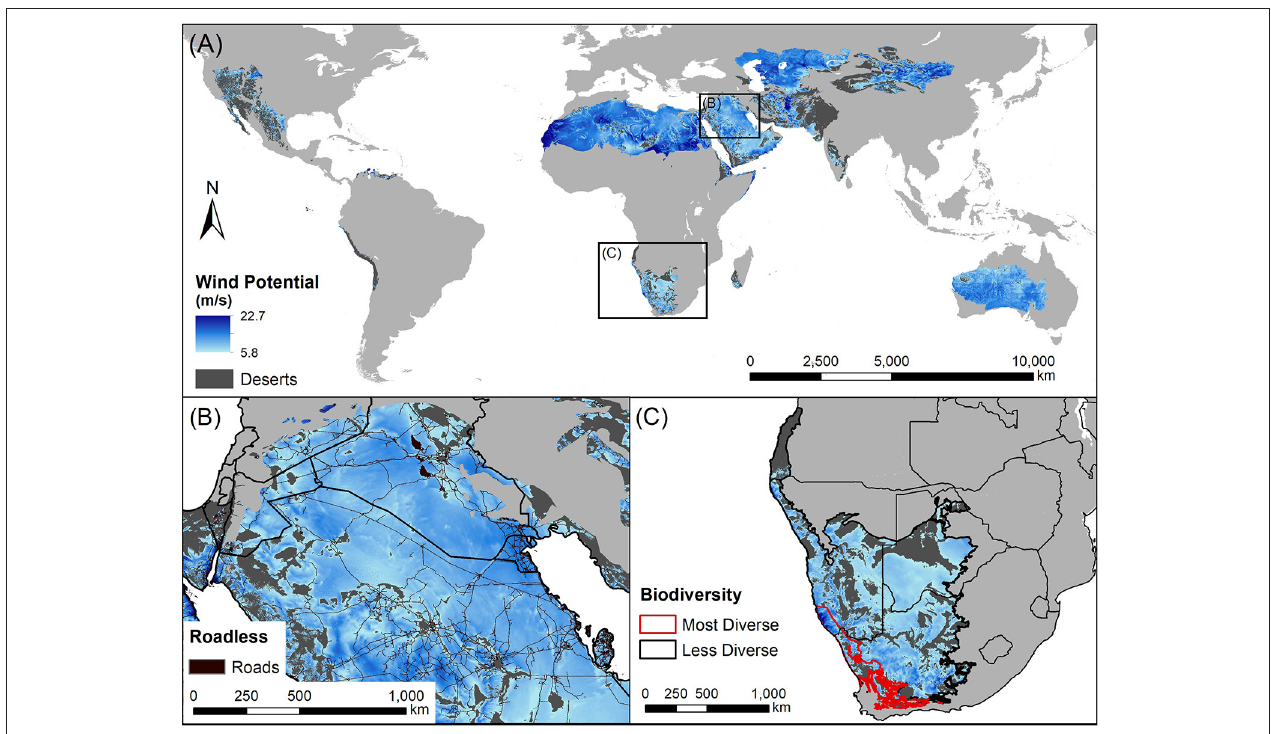
FIGURE 2 | Maps showing (A) the world’s deserts and overlap with economically valuable wind resources, (B) for Middle Eastern deserts, roadless areas, and wind resources, and (C) detail for southern African deserts with economically valuable wind resources and with the highly diverse Karoo ecoregion outlined. Blue-shaded areas represent high wind resource levels in all panels and as described in the legend for (A) .